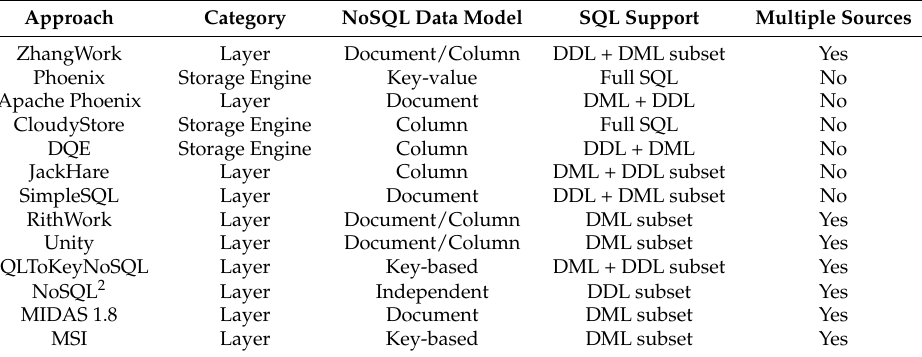
Table 3. Comparison of related